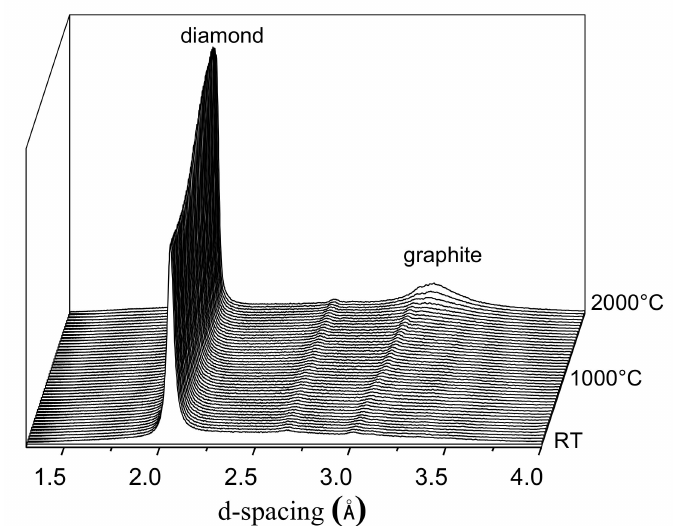
Figure 19. In situ X-ray diffractograms collected on heating (200 ◦ C/min) during HP-SPS treatment of a diamond nanopowder (PSICHE beamline, SOLEIL, in energy dispersion at a fixed